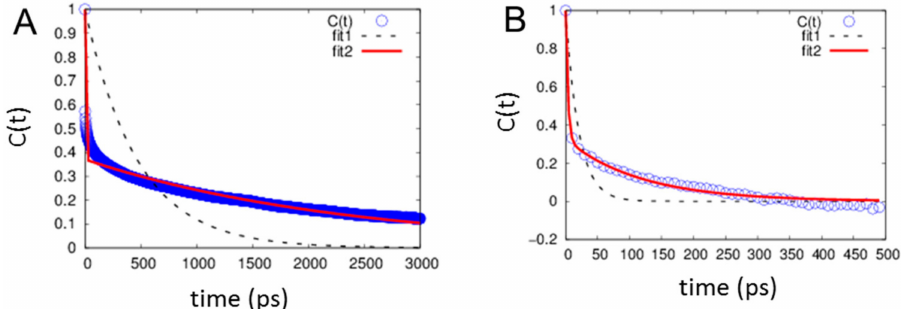
Figure 9. Time behavior of continuous HB correlation functions for System II ( A ) and System VII ( B